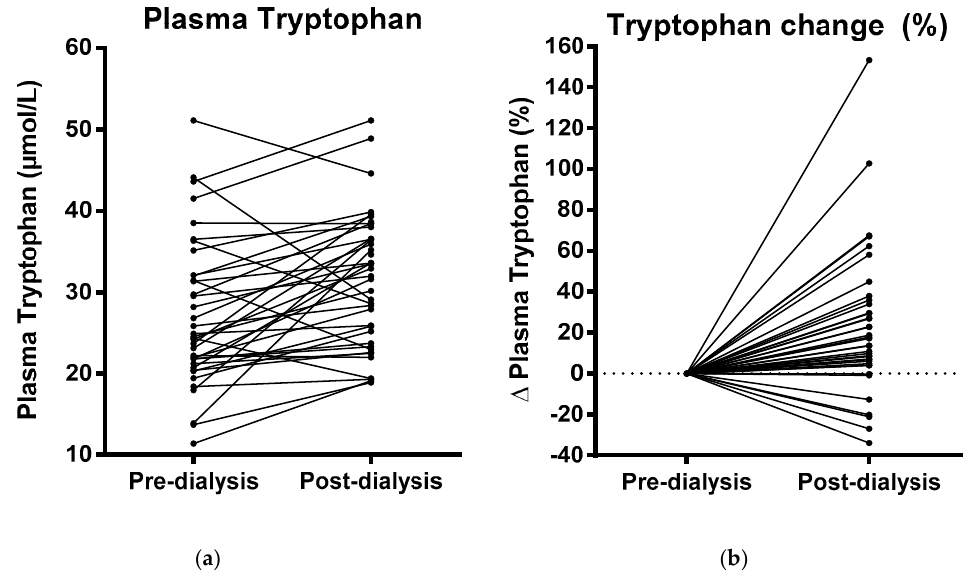
Figure 1. Plasma tryptophan concentrations before and after dialysis ( a ) and relative plasma tryptophan change during dialysis ( b ).